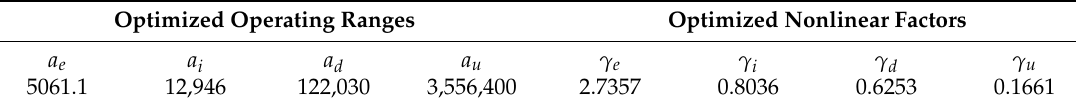
Table 4. The eight optimized parameters.